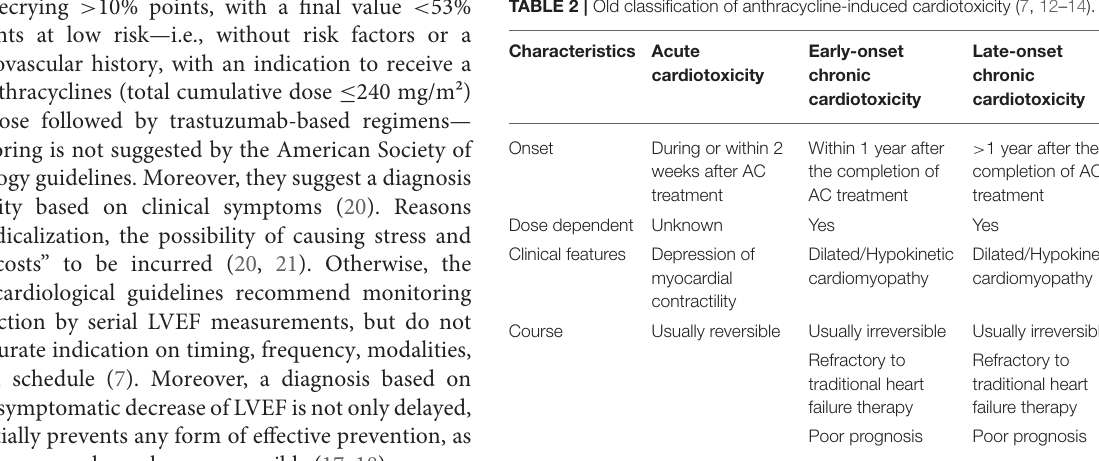
as an LVEF decrying > 10% points, with a final value < 53% TABLE 2 | Old classification of anthracycline-induced cardiotoxicity ( 7,